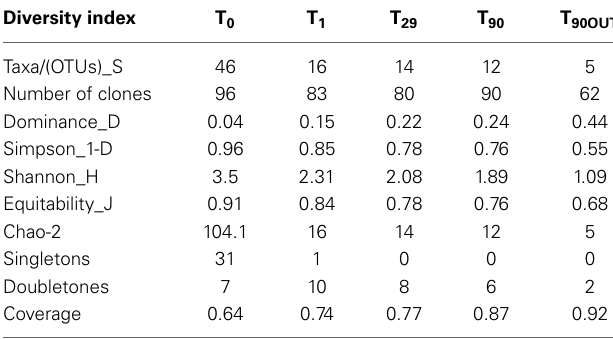
Table 4 | Diversity indices calculated for the five clone libraries created at different time of aeration and sediment ageing.